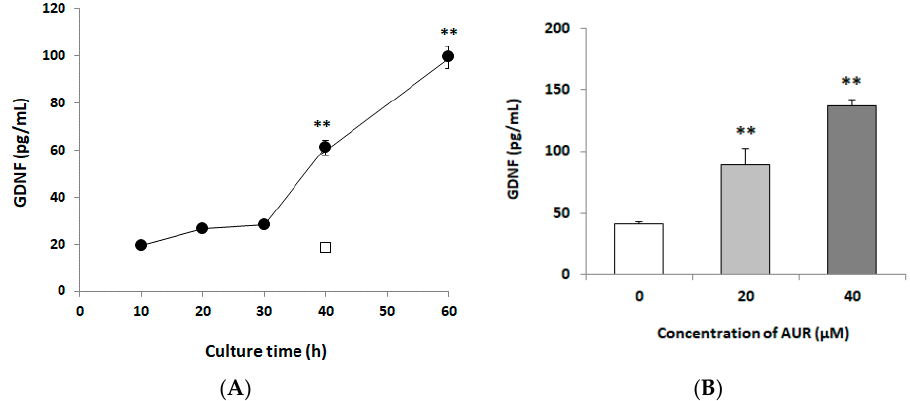
Figure 2. Effects of treatment with AUR on glial cell line-derived neurotrophic factor (GDNF) content in the medium of C6 cells. ( A ) Cells were incubated with 10 μ M AUR for various times (10–60 h) ( ● ) or without AUR for 40 h ( □ ). Significance difference in values between the non-treated cells (40 h) and other cells: ** p < 0.01; ( B ) Cells were incubated with various concentrations (0, 20, and 40 μ M) of AUR for 40 h. Significance difference in values between the non-treated (0 μ M) and AUR-treated cells: ** p < 0.01. In ( A ) and ( B ), the results are presented as the mean ± SEM ( n = 4).